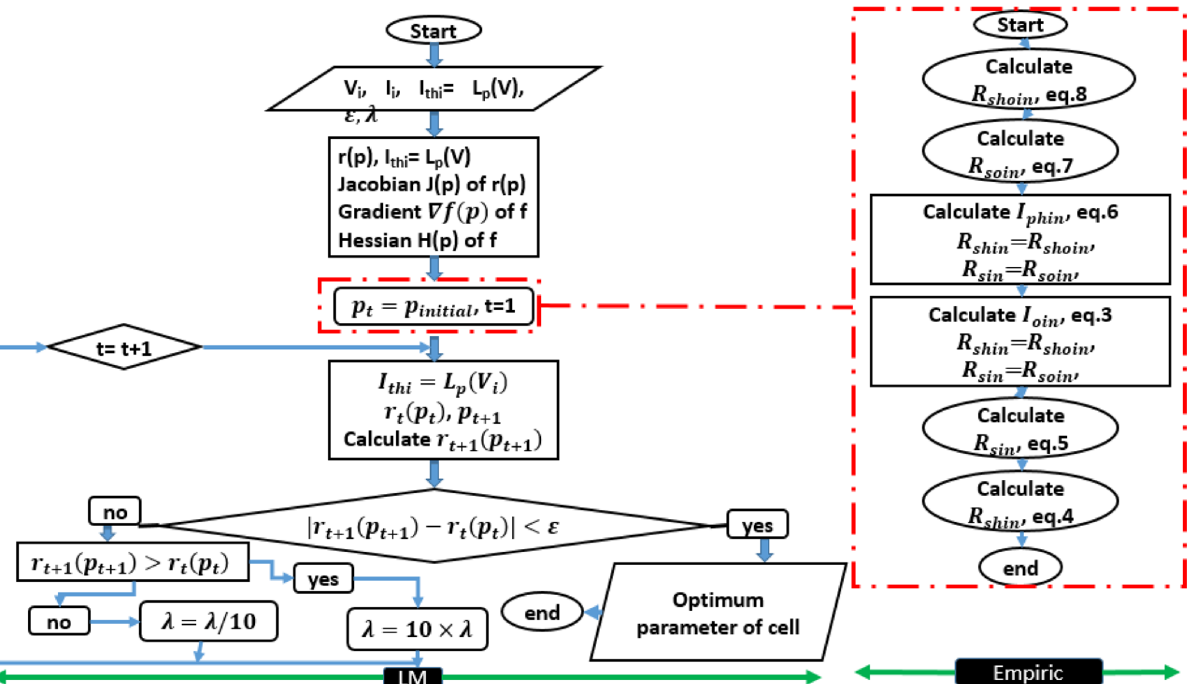
Fig. 3. Organigram of the cell parameters extracting